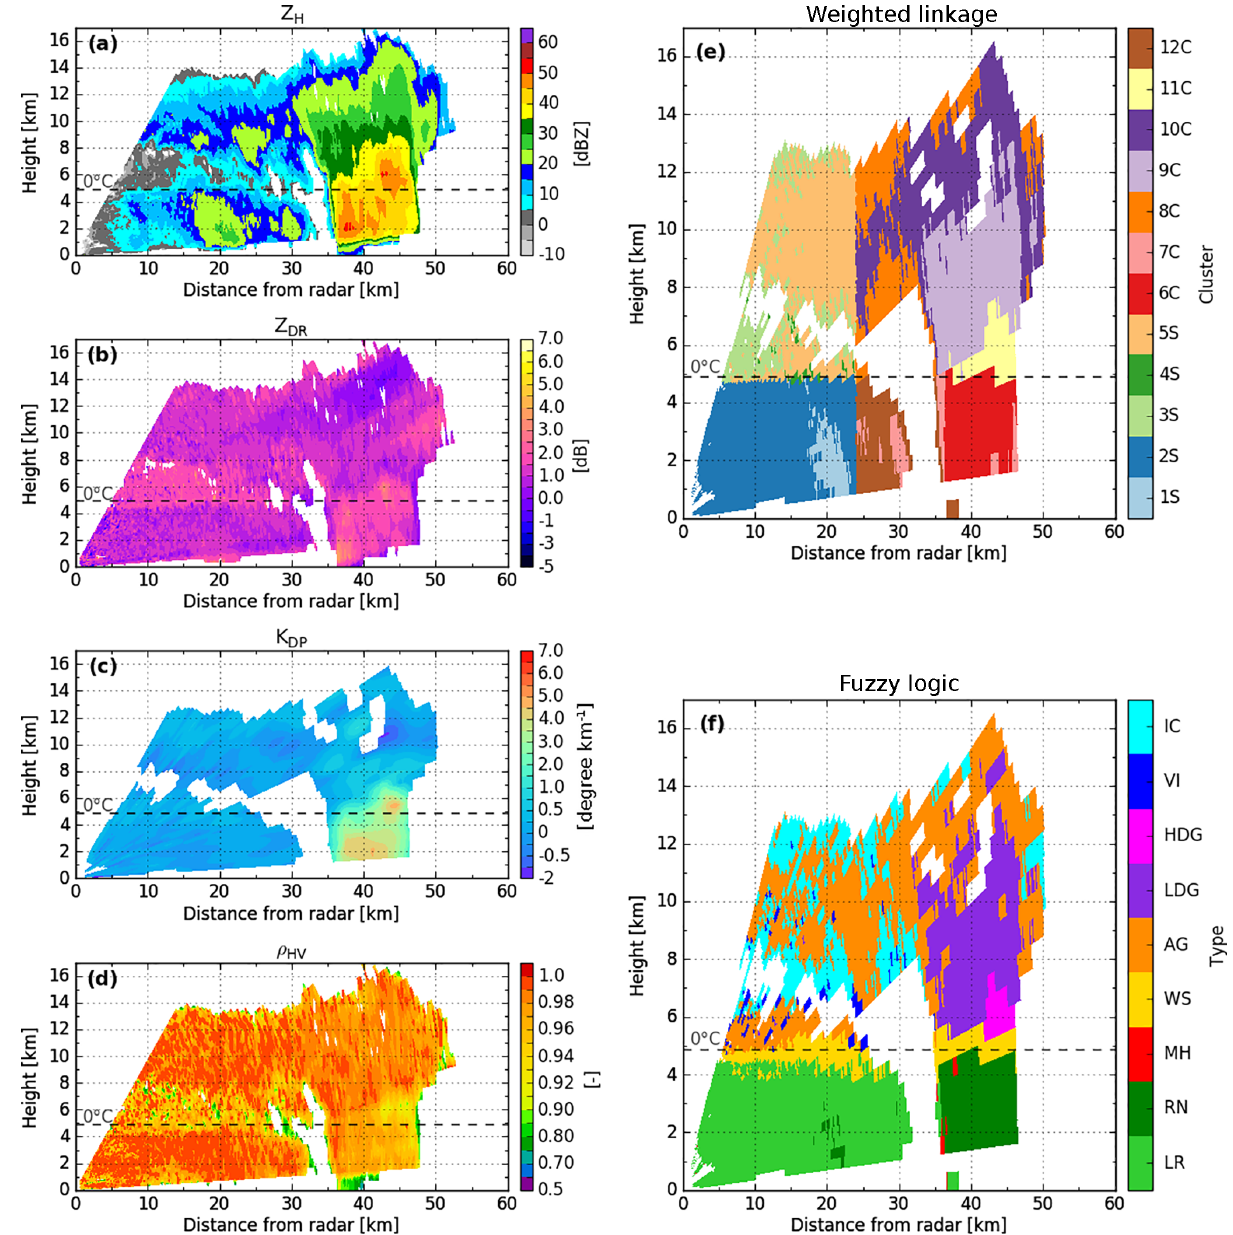
Figure 11. Same as Fig. 9, but for an RHI at 18:16UTC on 6 October 2014, along the azimuth 200 ◦